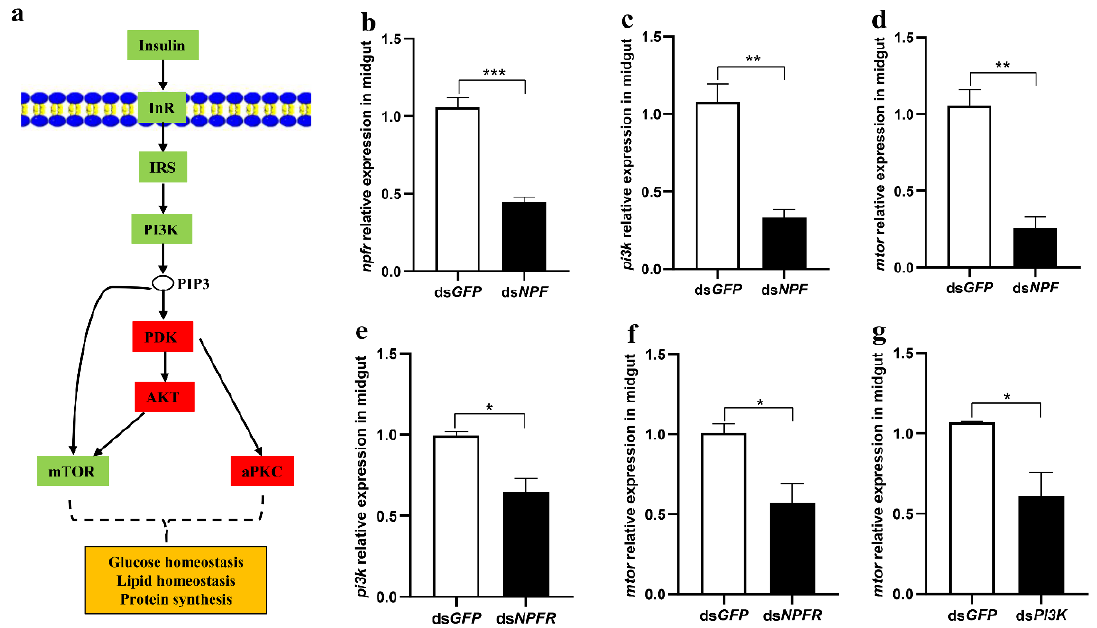
Figure 1. The relationship between npf and key genes in the insulin pathway in the midgut of O. furnacalis . ( a ) Diagram of insulin signalling pathways. ( b – g ) Transcript levels of npfr , pi3k and mtor in the midgut of 5th instar larvae with knockdown of NPF, NPFR, and PI3K, respectively, for 24 h. Each treatment was repeated 3 times with 10 individuals per replicate. Bars represent the mean ± SE. * p < 0.05, ** p < 0.01, *** p < 0.001.